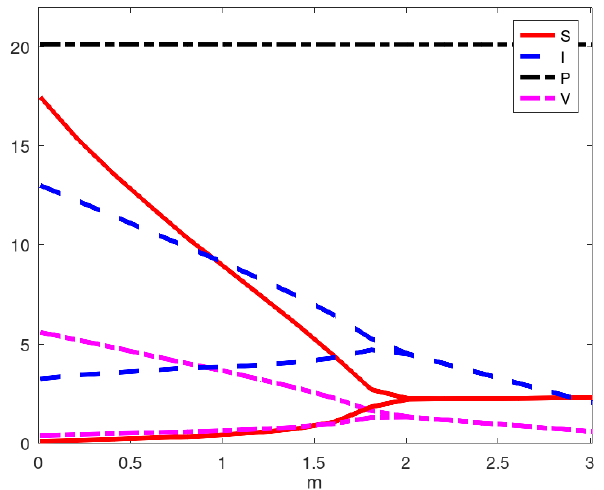
Figure 8. Hopf bifurcation diagram in terms of the parameter 0 < m < µ . Above the critical threshold m † = 2.0, the cycles are damped, and the stable coexistence equilibrium (cid:98) E ∗ is achieved. The two curves in the left portion of the diagram denote the peaks and the troughs of the oscillations. The other parameters are given in (29), and the initial conditions are